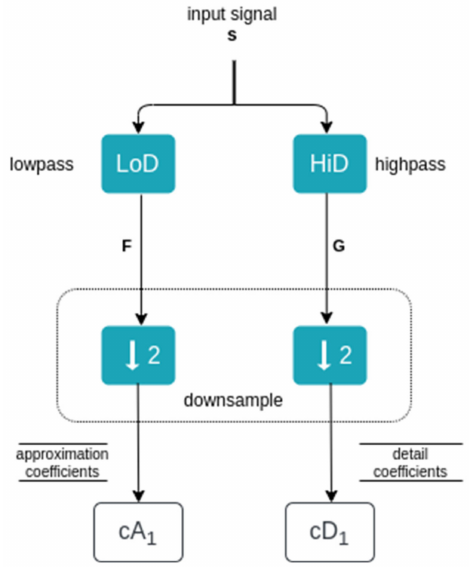
Figure 1. Wavelet decomposition